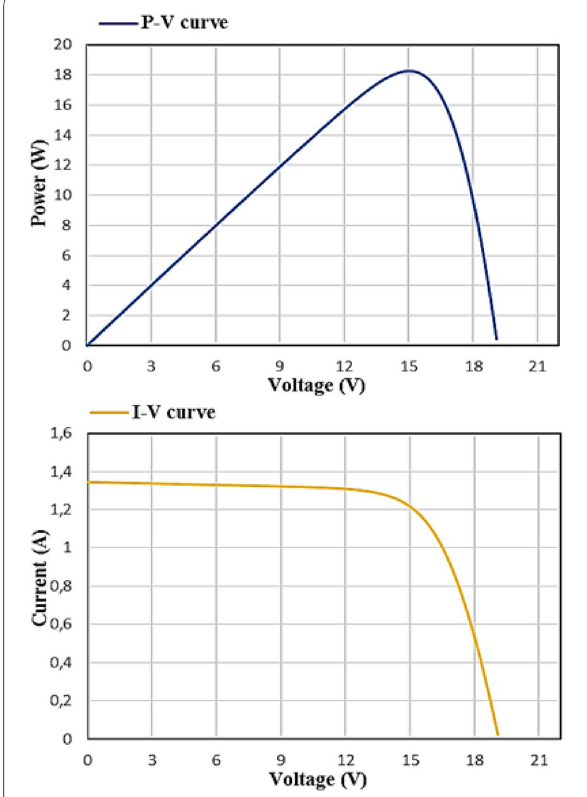
Fig. 17 I – V and P – V characteristics for PV panel under